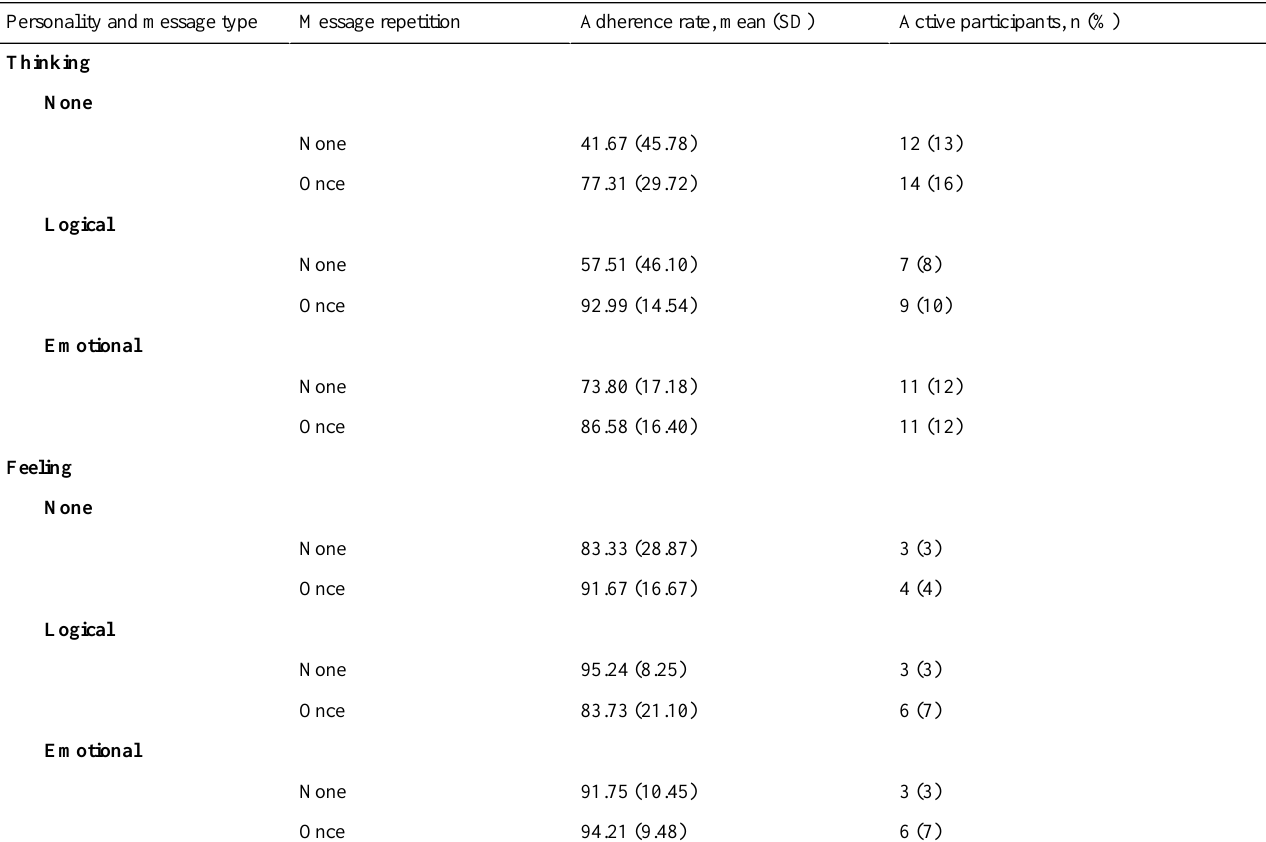
Table 1. Descriptive statistics of the active participants in each group.